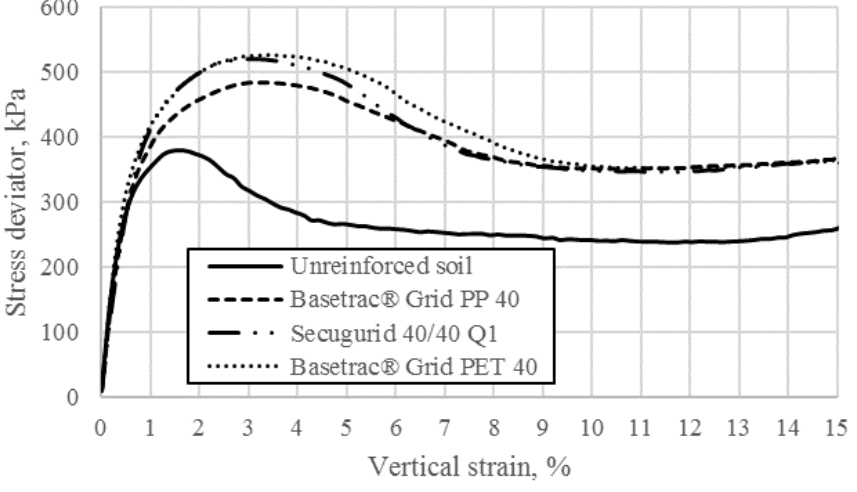
Figure 4: Dependence of stress deviator on the vertical strain of unreinforced and reinforced soil samples with geogrids when the cell pressure σ = 100 3